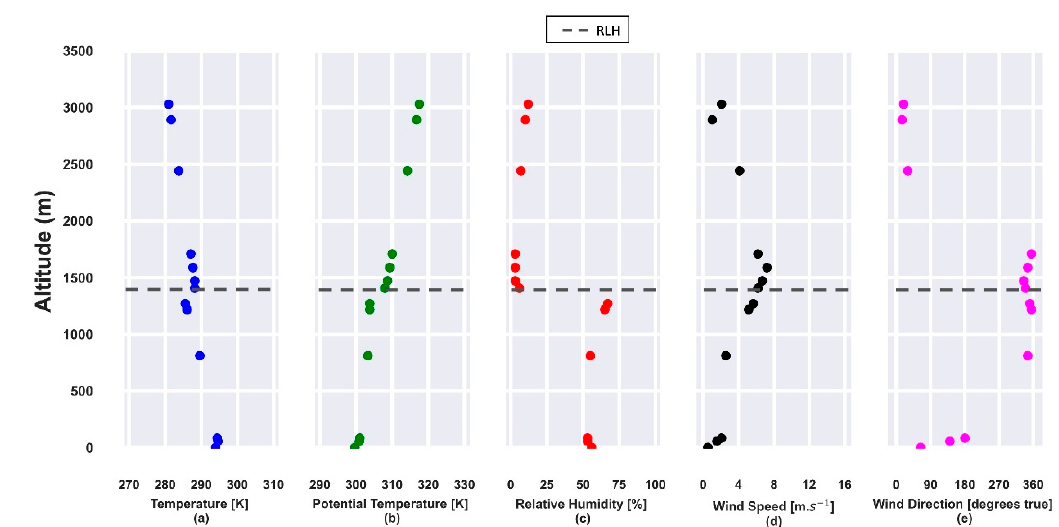
Figure 8. Atmospheric parameters obtained from radiosonde data on 24 July 2019 at 00:00 UTC. ( a ) Temperature [K]; ( b ) potential temperature [K]; ( c ) relative humidity [%]; ( d ) horizontal wind speed [m·s − 1 ]; ( e ) wind direction [degrees true]. The gray dashed line represents the RLH.